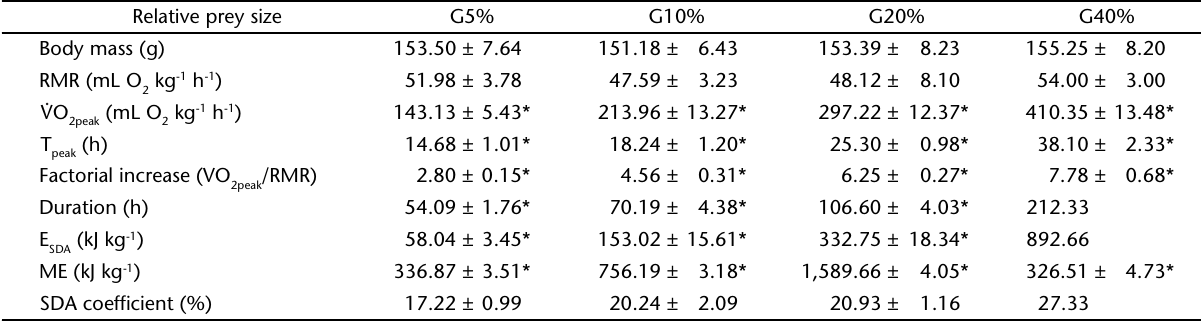
Table I. Metabolic and energetic parameters associated with the SDA of Bothrops alternatus fed on meals with different relative sizes (G5% to G40%) at 30°C (mean values ± SE). RMR, resting metabolic rate; VO taken to reach VO ; E , energetic cost of digestion; ME, energy content of the meal; SDA coefficient, percentage of the energy 2peak SDA ) in relation to meal energy (ME). N = 6 in all cases except for Duration, E expended in SDA (E SDA = 1, see text for details). Groups identified with an asterisk are statistically different to each other.